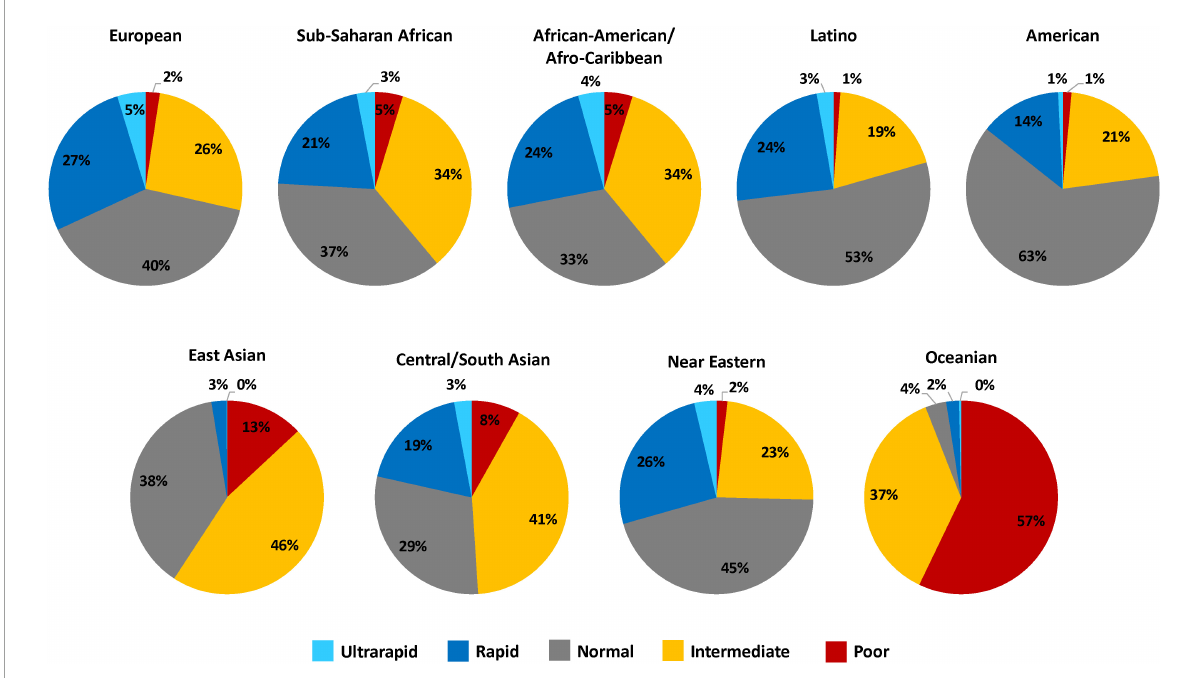
FIGURE1 CYP2C19 metabolizer phenotype frequency estimates across diverse biogeographical groups. This figure summarizes the relative frequency estimates (in percentages) of CYP2C19 metabolizer phenotypes in the 9 distinct biogeographical groups defined by PharmGKB to annotate racial and ethnicity information about participants in pharmacogenomic studies (21). The CYP2C19 metabolizer phenotype and respective CYP2C19 genotypes are as categorized: ultrarapid metabolizers ( ∗ 17/ ∗ 17 ), rapid metabolizers ( ∗ 1/ ∗ 17 ), normal metabolizers ( ∗ 1/ ∗ 1 ), intermediate metabolizers (e.g., ∗ 1/ ∗ 2 or ∗ 2/ ∗ 17 ), and poor metabolizers (e.g., ∗ 2/ ∗ 2 ). Frequency data was obtained from CPIC